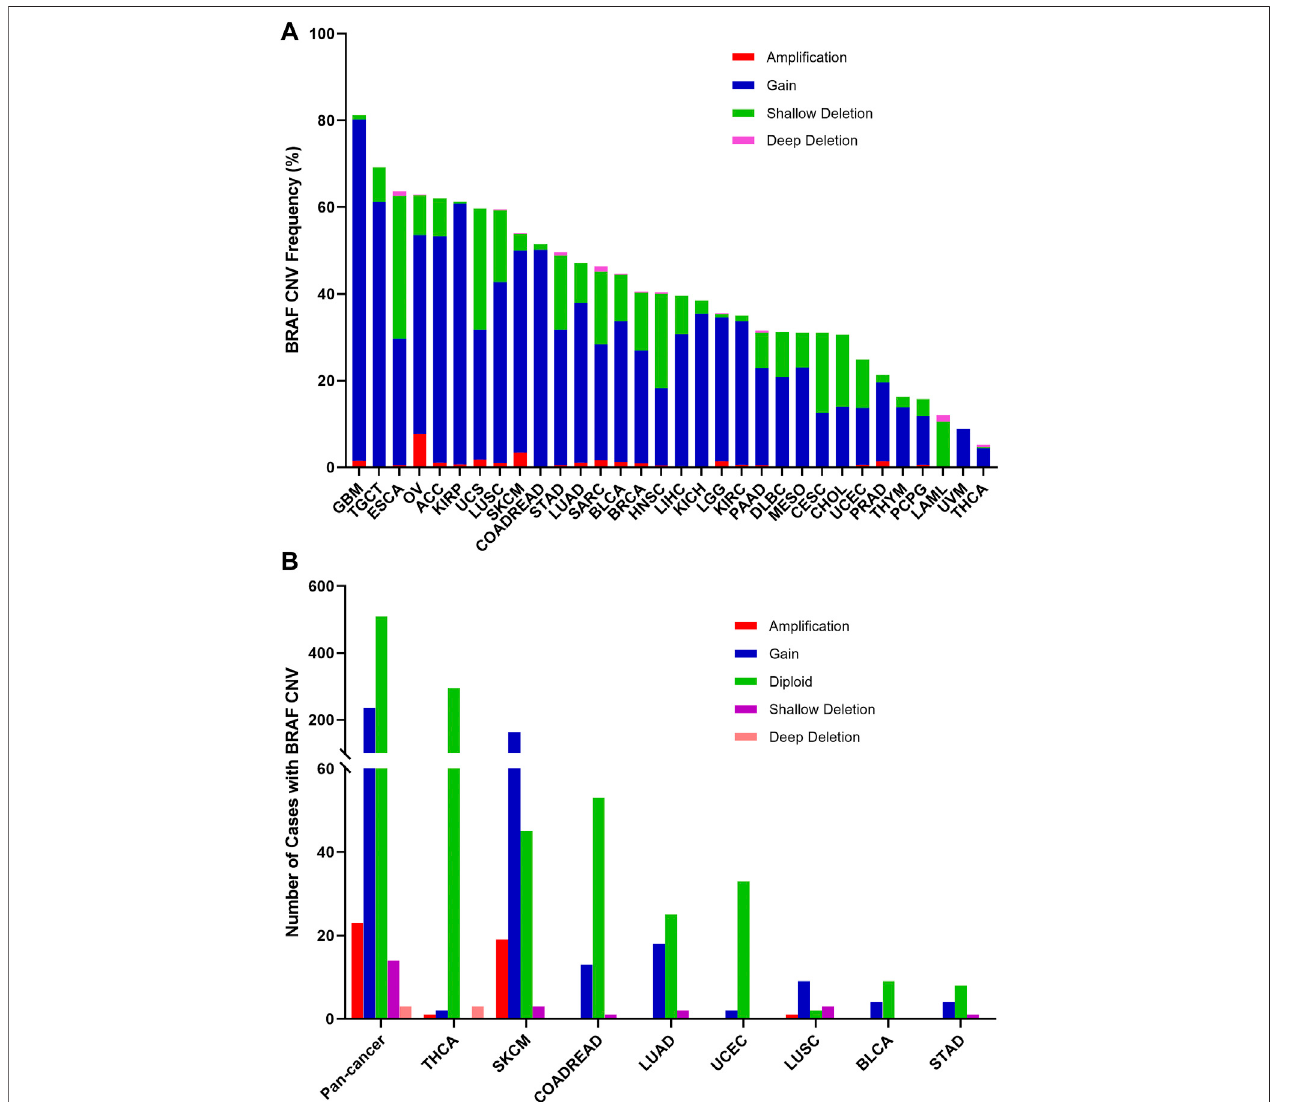
FIGURE 6 | BRAF Copy Number Variant (CNV) distribution across all and selected top 8 cancer types. (A) BRAF CNV frequency in 32 TCGA cancer types. (B) BRAF CNV distribution in pan-cancer and the top 8 cancer types for the cases with EGFR mutations.